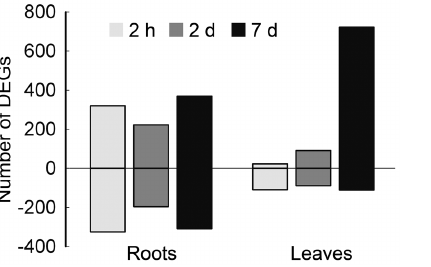
Figure 1. General features of the DEGs in the tested tissues. The number of upregulated genes (p value , 0.01, salt/control $ 1.8) was shown in upward bars and the number of downregulated genes (p value , 0.01, control/salt $ 1.8) was shown in inverted bars. DEGs, differentially expressed genes.